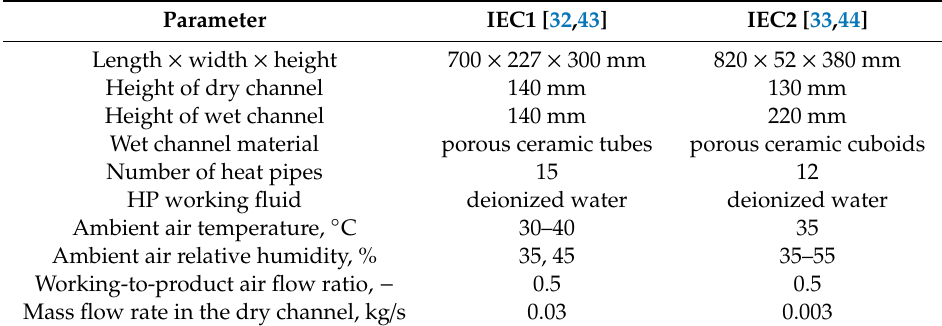
Table 5. Detailed specifications of the experimental studies